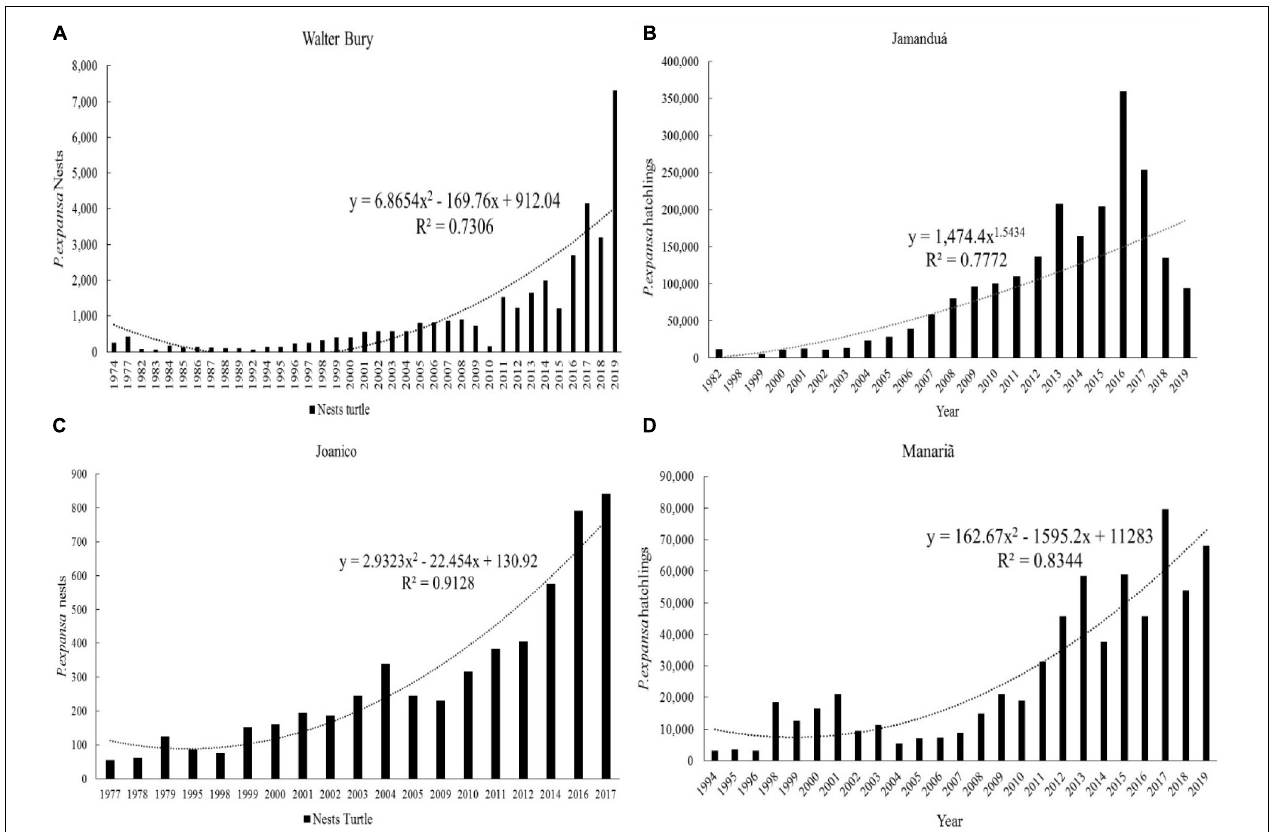
FIGURE 8 | Time series of the production of P. expansa nests and hatchlings at nesting sites of the Juruá and Purus Rivers: (A) Nests—Walter Bury; (B) Hatchlings—Jamanduá; (C) Nests—Joanico; (D) Hatchlings—Manariã.